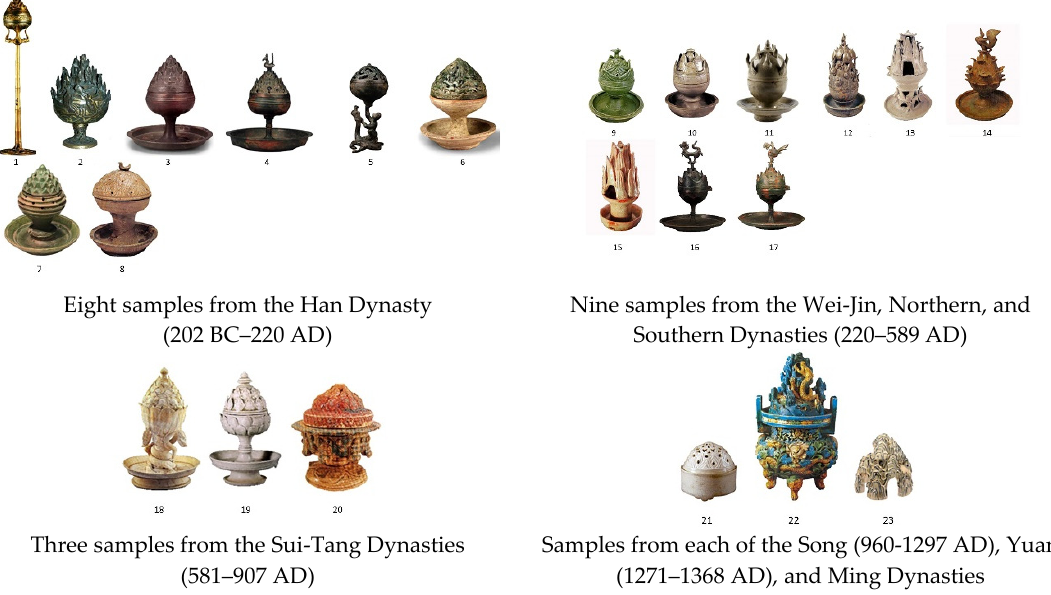
Figure 1. The 23 Boshanlu samples chosen for this case study.